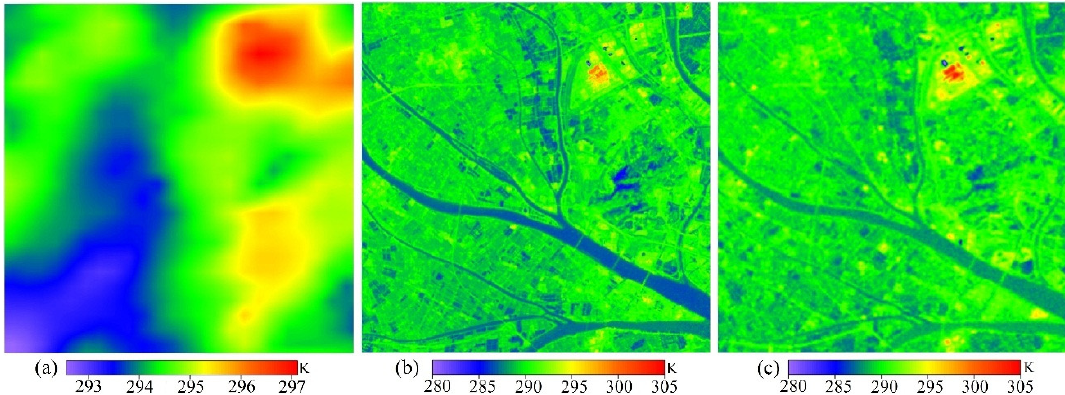
Figure 8. SADFAT result in simulated experiment. (a) MODIS LST images resampled from 1 km to 30 m; (b) SADFAT-derived image at 30 m; (c) up-scaled Landsat ETM+ LST image at 30 m spatial on 7 December